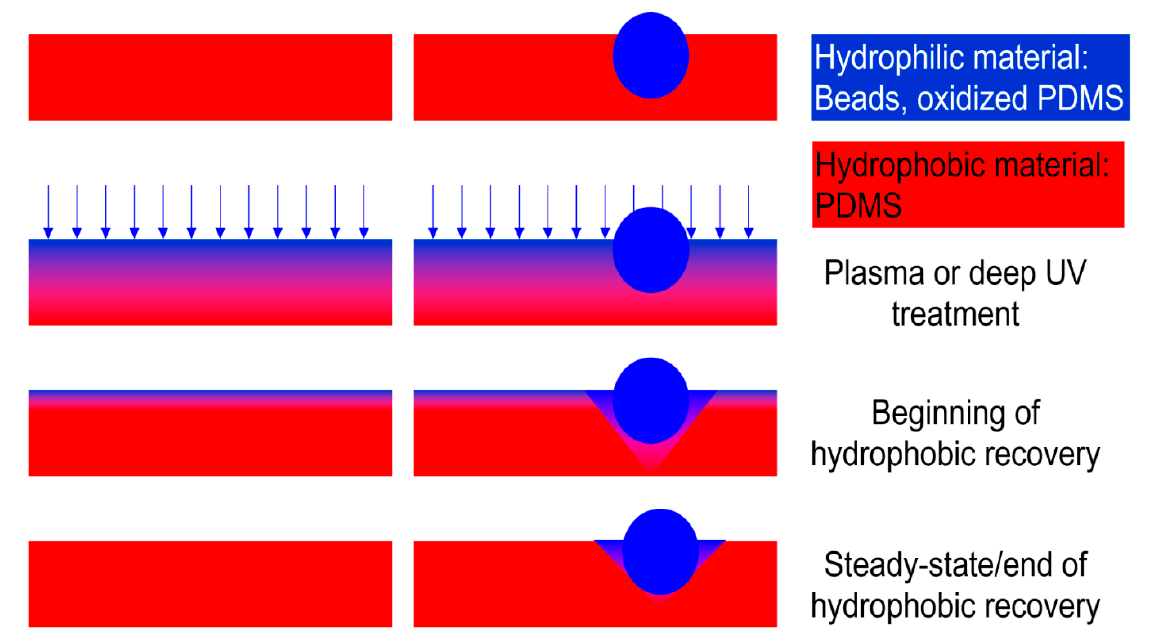
Figure 8. Mechanism of hydrophobic recovery for bare PDMS and PDMS embedded with hydrophilic beads.